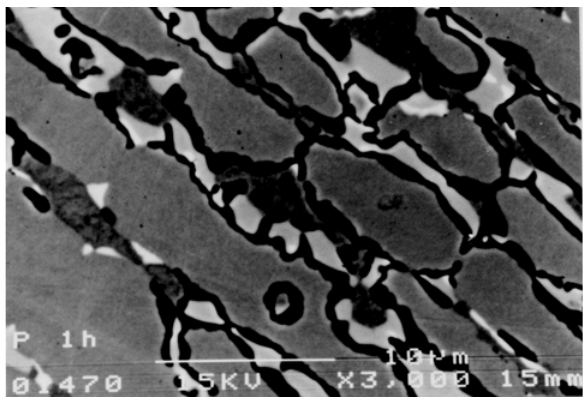
Figure 9. Localized corrosion along the sigma/austenite interface (con- tinuous black strips) on the heat-treated AV2205 alloy at 850 °C/1 h after the cyclic potentiodynamic test. SEM - primary electrons image. 3000X.